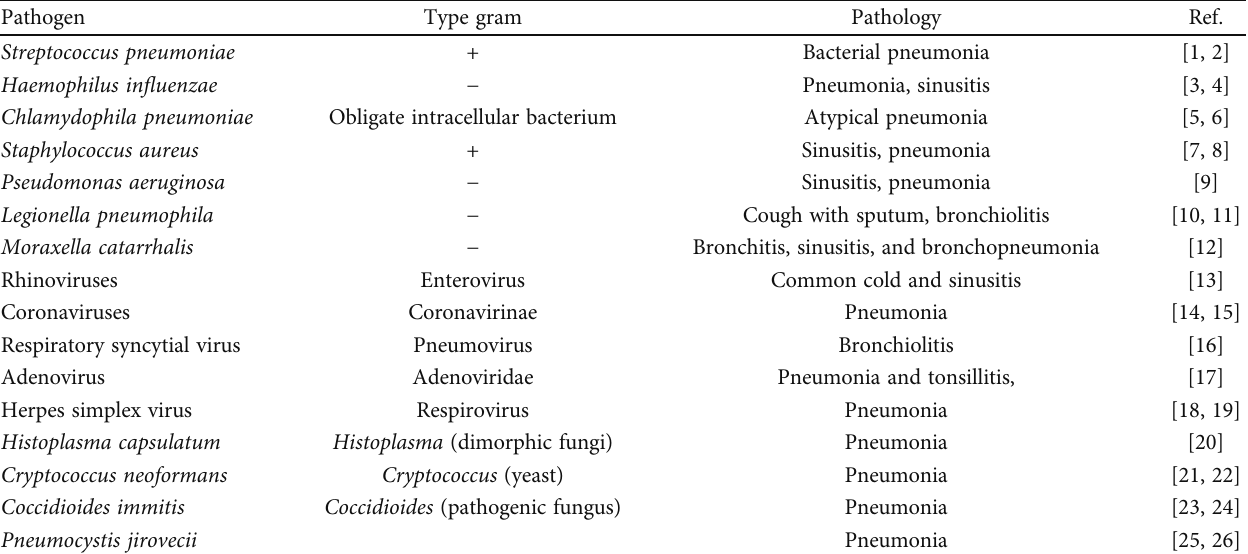
Table 1: Common pathogens concerned in respiratory tract infections (bacteria, viruses, and fungi).